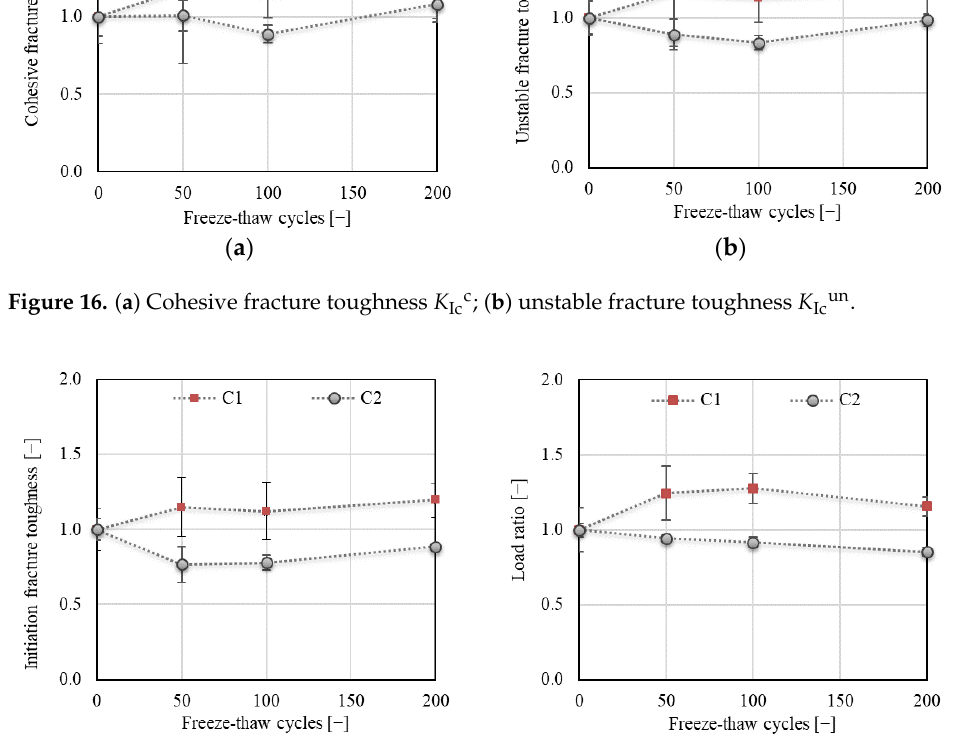
Figure 17. ( a ) Initiation fracture toughness K Ic ini ; ( b ) load F ini /F max